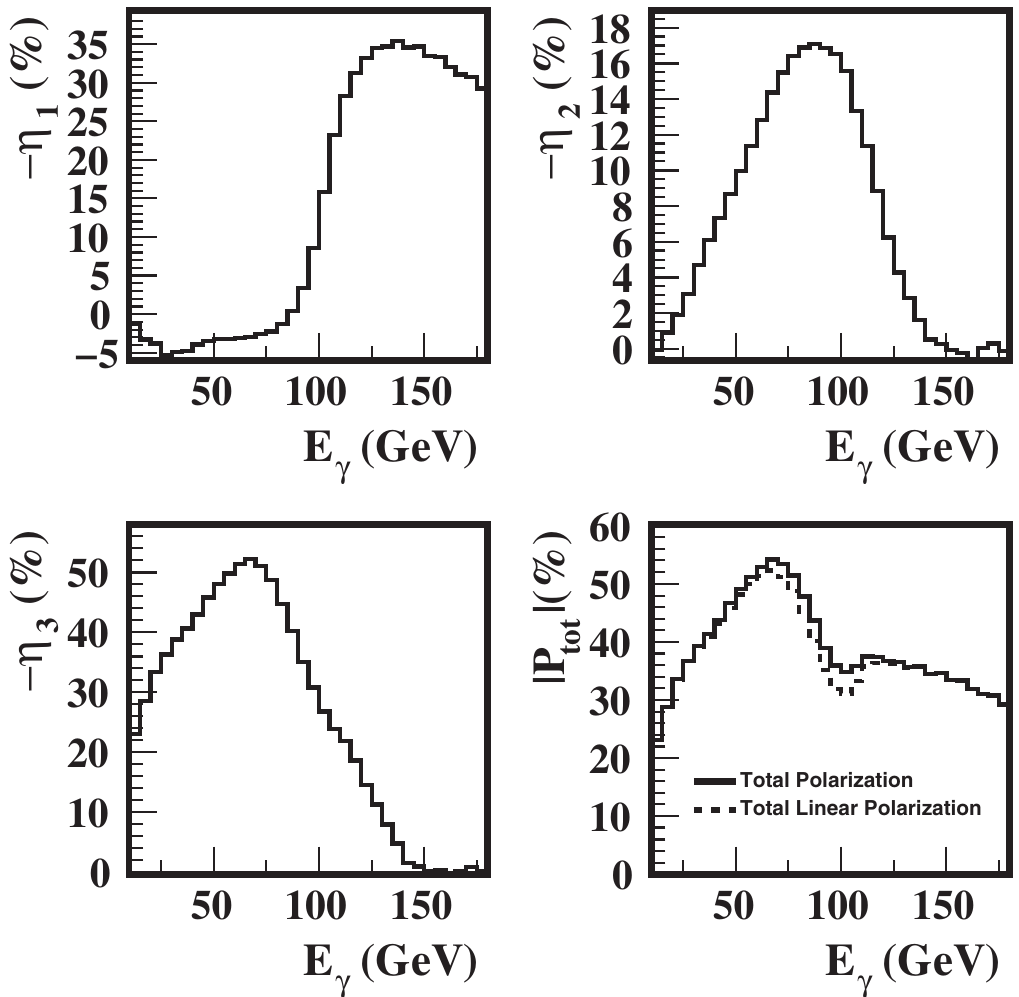
FIG. 20. Stokes parameters after the quarter wave crystal, assuming as input the values given in Fig.